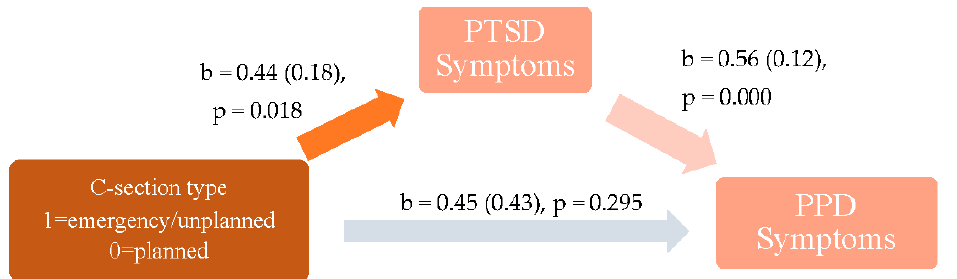
Figure 1. Unadjusted model for the association between C-section type (i.e., emergency C-section to planned C-section) and PTSD and PPD symptoms.